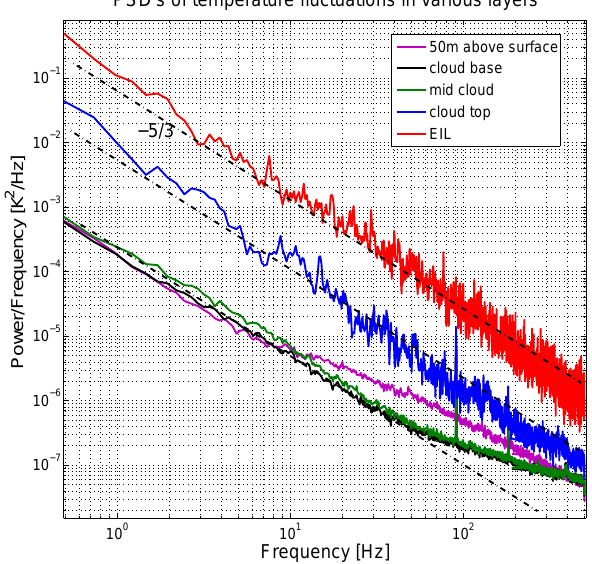
Fig. 11. Example PSDs of temperature fluctuations of a 1kSs − 1 signal collected at various levels of a turbulent stratocumulus topped boundary